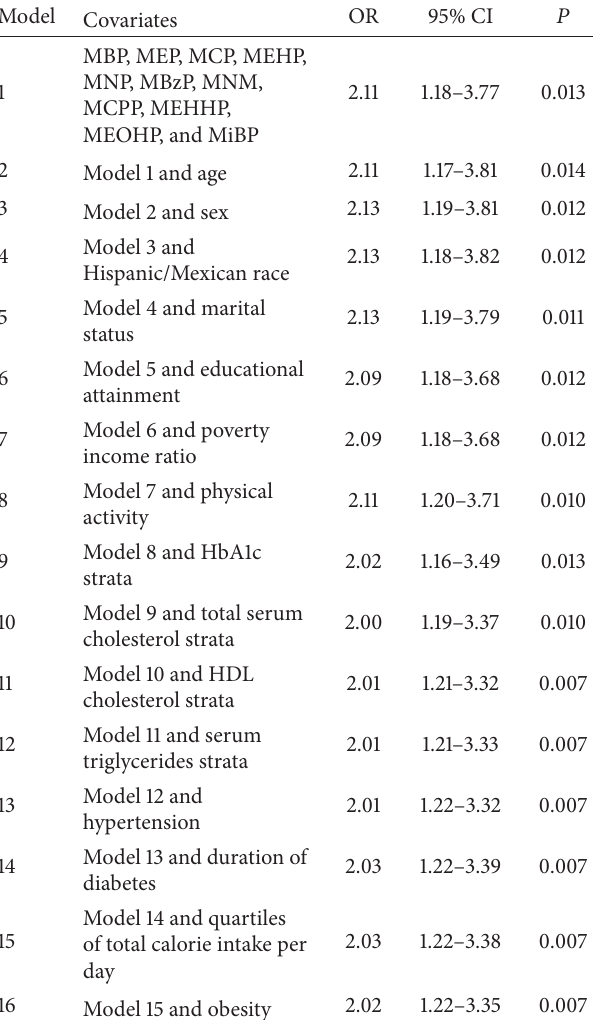
covariate definitions are provided in Table